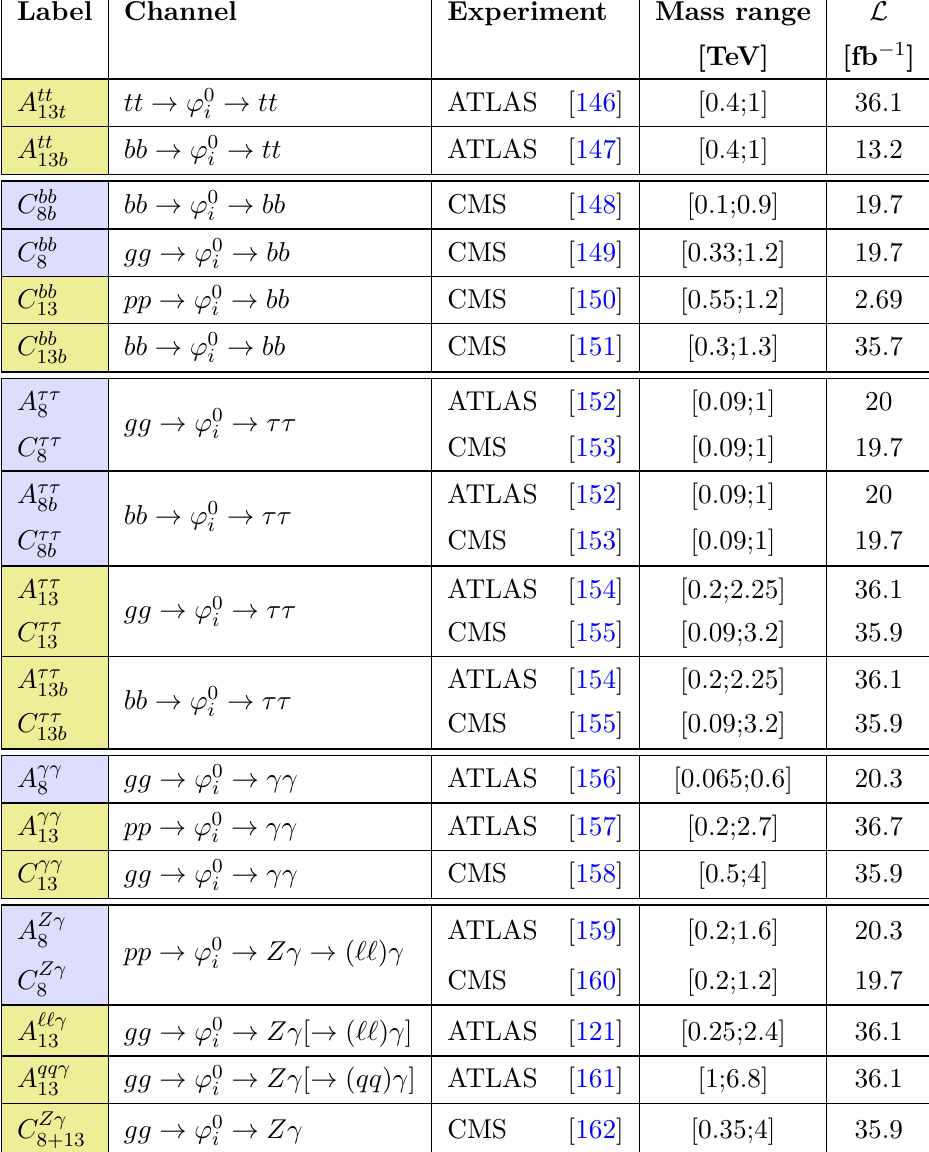
Table 6. Direct searches for neutral heavy scalars, ϕ 0 photons and Zγ final